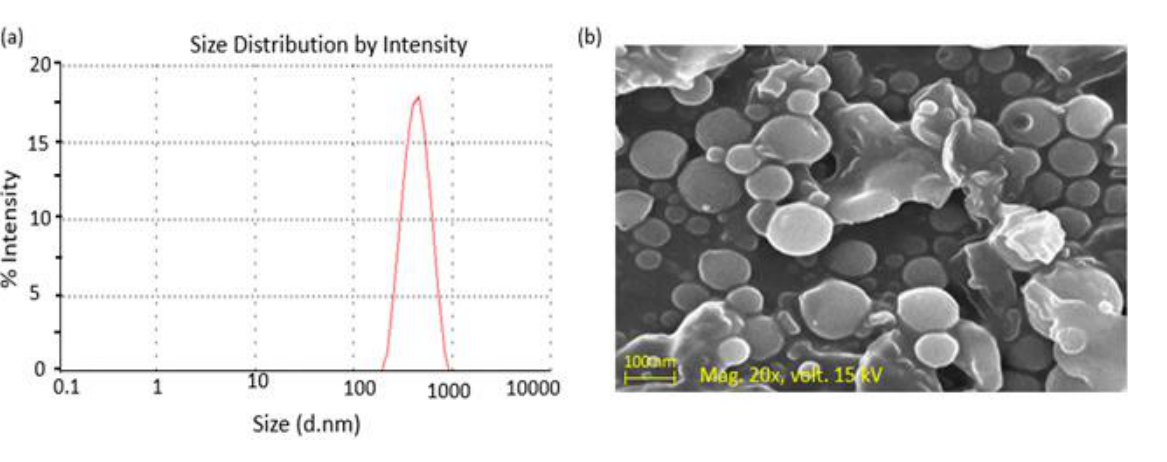
Figure 2. Particle size distribution ( a ) and SEM morphology of chitosan NPs containing voriconazole of formulation VRZNC ( b ).